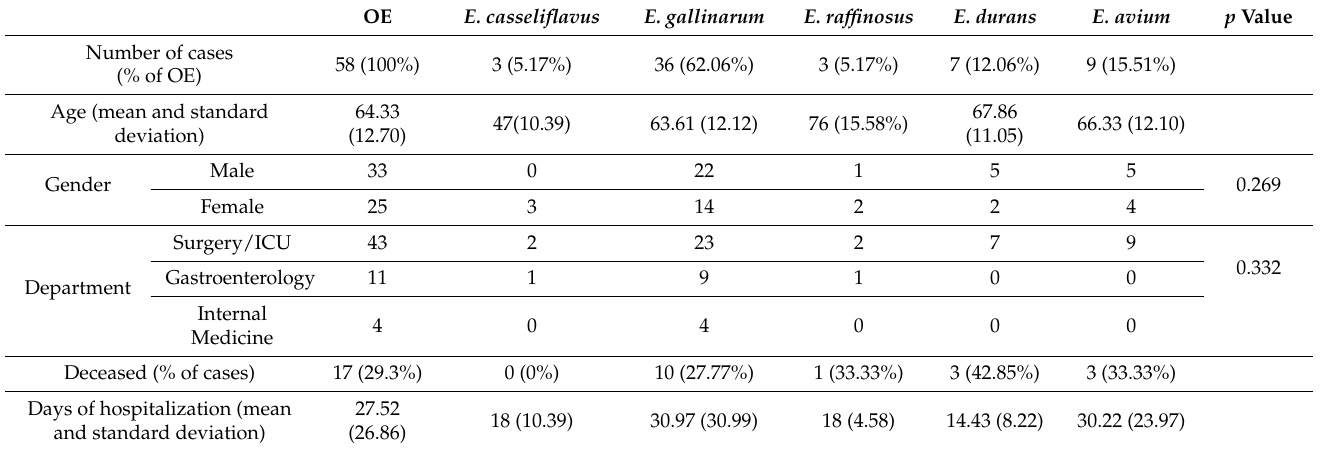
Table 1. Patient characteristics according to other Enterococci species.